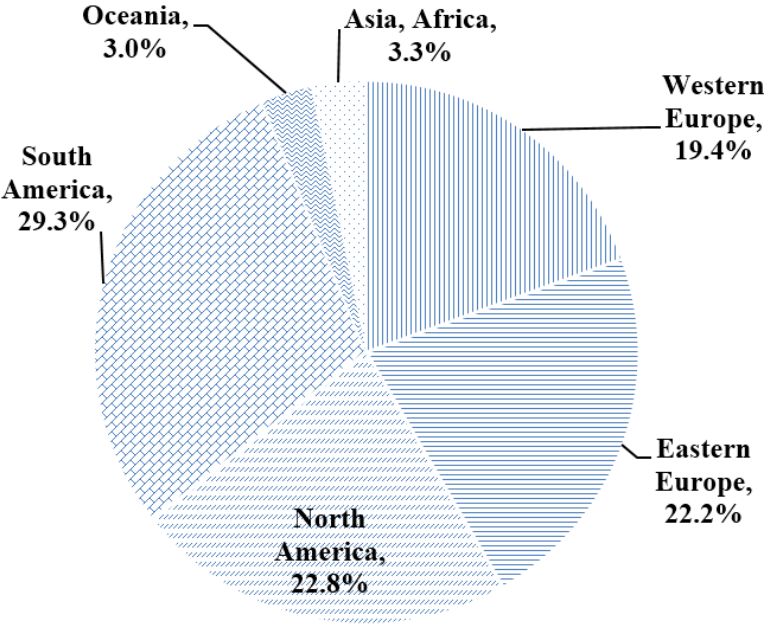
Figure 1. Combine world market in 2004. Source: New Agriculture (adapted from [5]). Eastern Europe offers good prospects for increasing sales of harvesters, particularly the CIS countries (Commonwealth of Independent States—former Soviet republics, excluding the Baltic States). bankruptcy. Before the political changes, 35,000 units were produced annually in the Soviet Bloc.